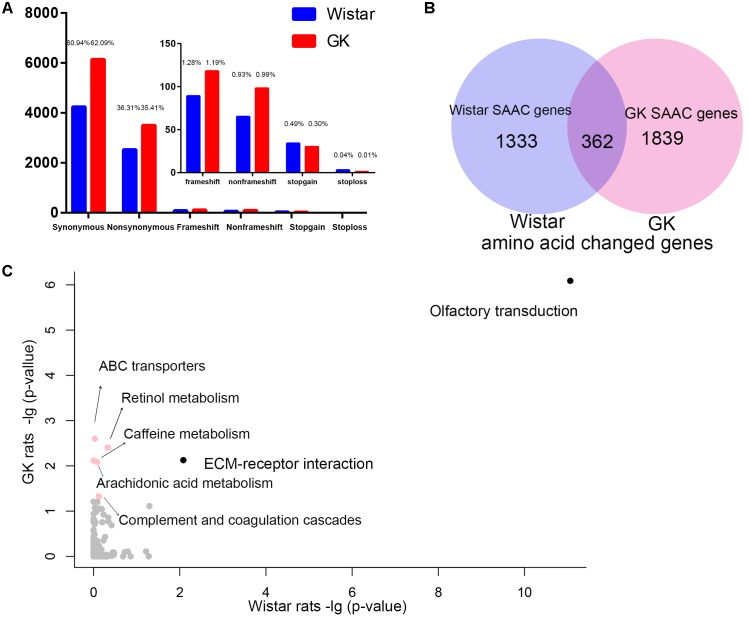
The exonic region fixed variants and the amino acid changed genes in GK and Wistar rats. (A) Distribution of synonymous, non-synonymous, and deleterious fixed variants (frameshift, non-frameshift, stopgain and stoploss) of the fixed homozygote variants in the exonic region of GK (red) and Wistar (blue), respectively. (B) Venn diagram of GK and Wistar amino acid changed genes. The GK/Wistar SAAC genes mean that the gene only exists as a the amino acid changed gene in GK/Wistar rats. (C) Data represents the –log(P-value) of the enrichment pathways in GK and Wistar SAAC genes. Enrichment pathways with high confidence [–log(P-value) > 1.3, p < 0.05] in different colors.